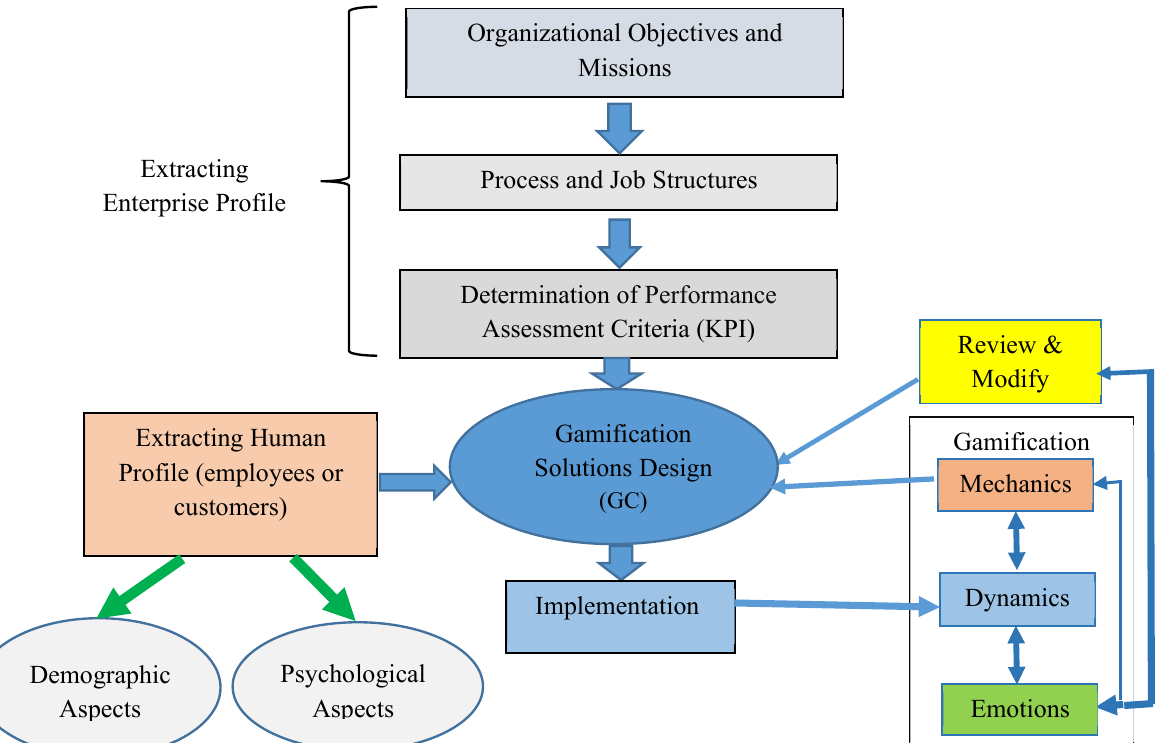
Fig. 4. The proposed methodology for enterprise